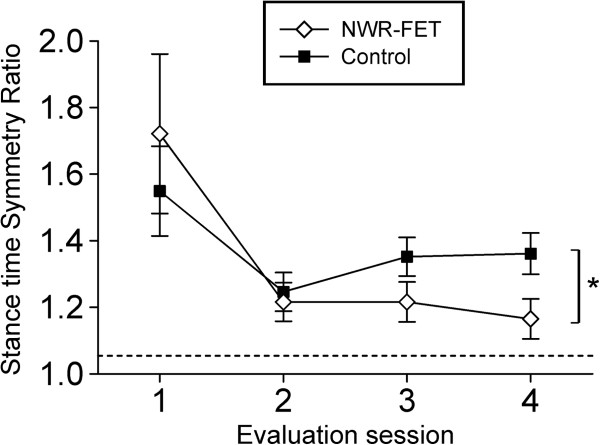
Stance time Symmetry Ratio. Symmetry Ratio at inclusion (evaluation 1), immediately after completion of training (evaluation 2), 1 month (evaluation 3), and 6 months (evaluation 4) after completion of training. The Symmetry Ratio was calculated as the ratio between the duration of the stance time in the paretic limb and the stance time in the contralateral limb, provided that the larger of the two values is used in the numerator. The stippled horizontal line represents the normative cut point of 1.05. Asterisk indicates a statistically significant difference between groups after finishing treatment (p < 0.02).